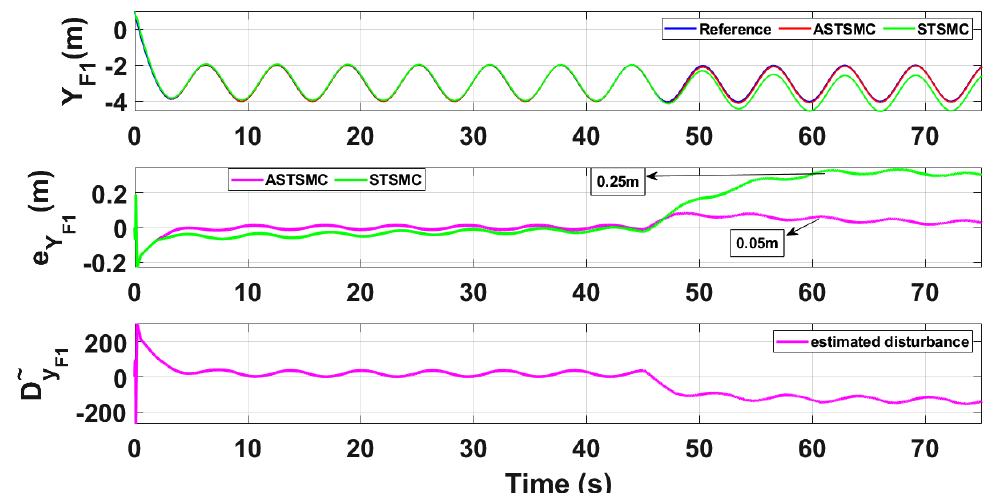
Figure 12. Y F 1 tracking comparison under wind